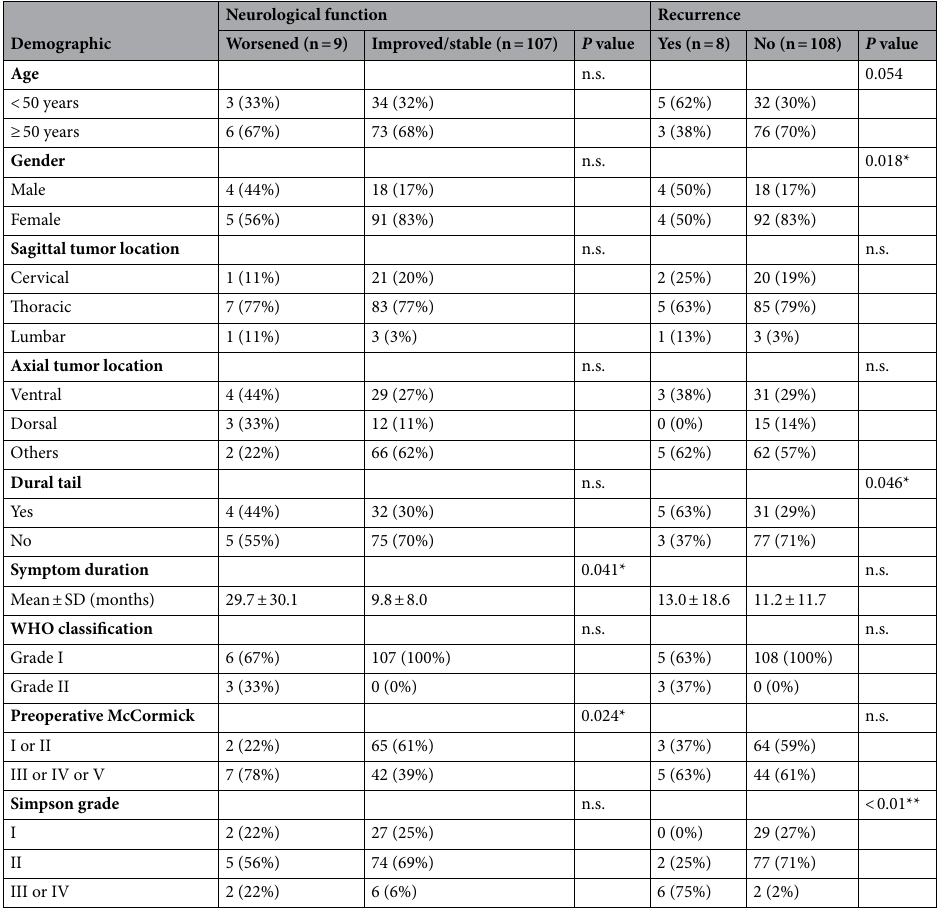
Table 5. Factors associated with postoperative neurological function and prognostic factors for recurrence. Significant difference *P < 0.05, **P <